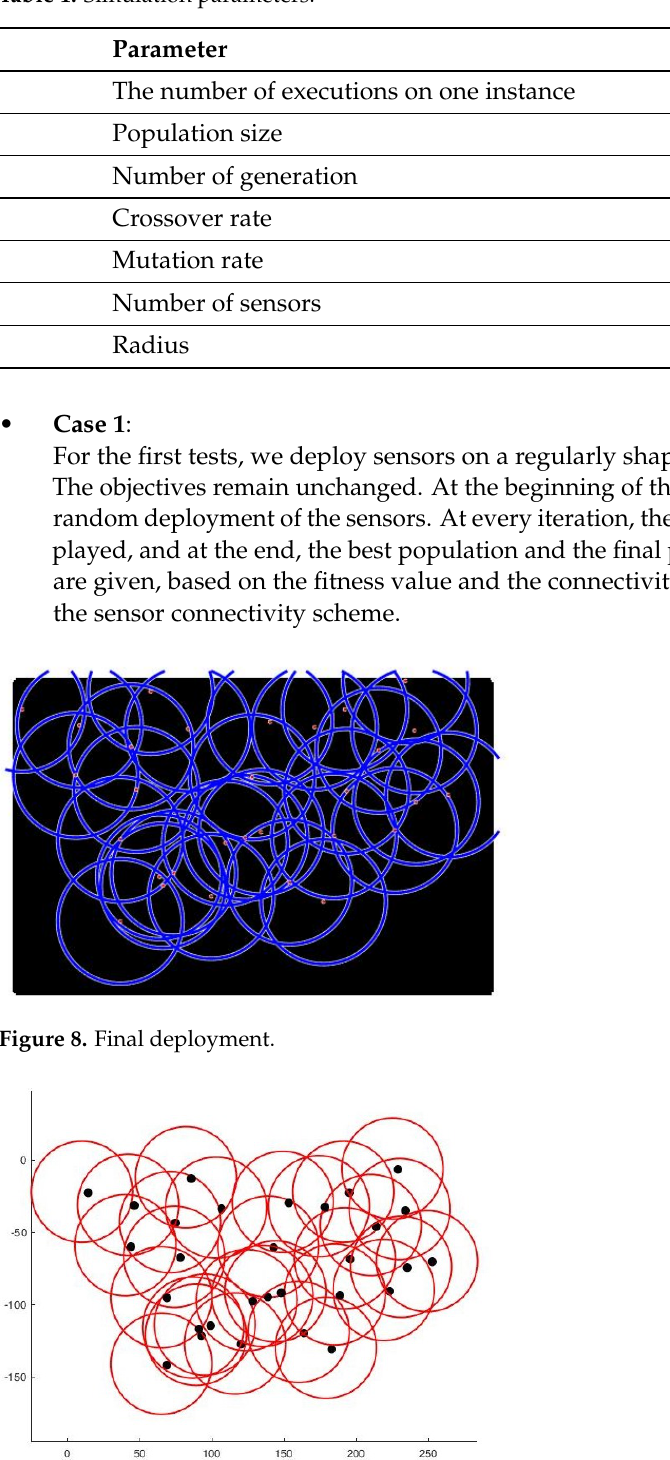
Table 1. Simulation parameters.